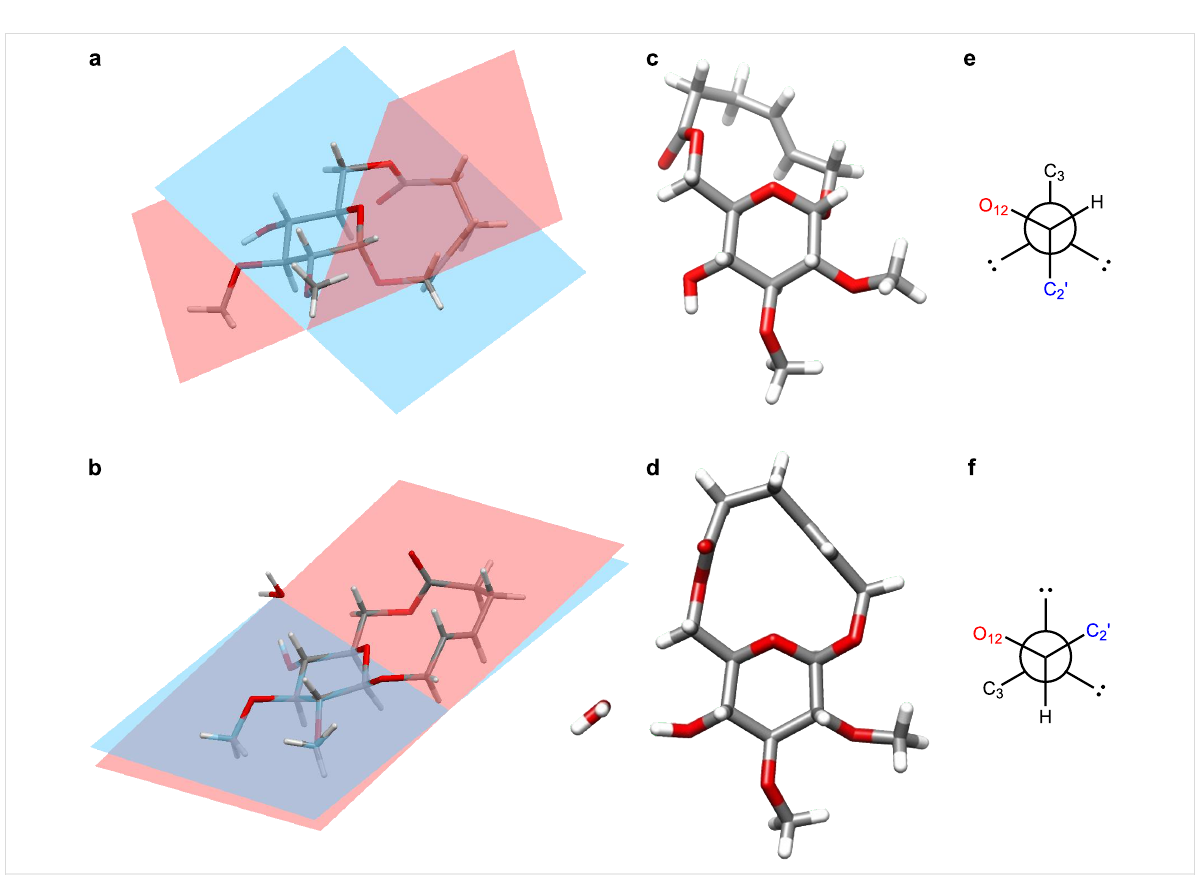
Figure 3: Structures of 5 and 6 from X-ray crystallographic data; a) and b) side views of 5 (a) and 6 (b) with mean plane of macrocycle in blue and D-glucose in red; c) and d) views of 5 and 6 from an angle perpendicular to the D-glucose plane; e) and f) Newman projections, sighting down the glycosidic bond, of 5 and 6